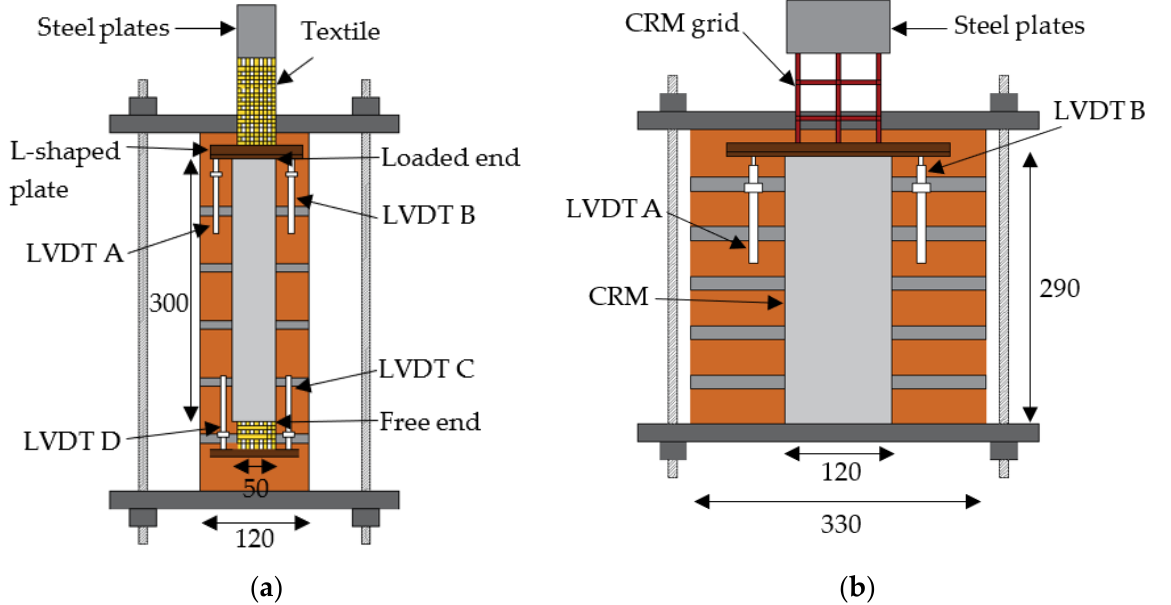
Figure 2. ( a ) Sketch of single-lap direct shear test set-ups used for ( a ) FRCM and SRG and ( b ) CRM (dimensions in mm).